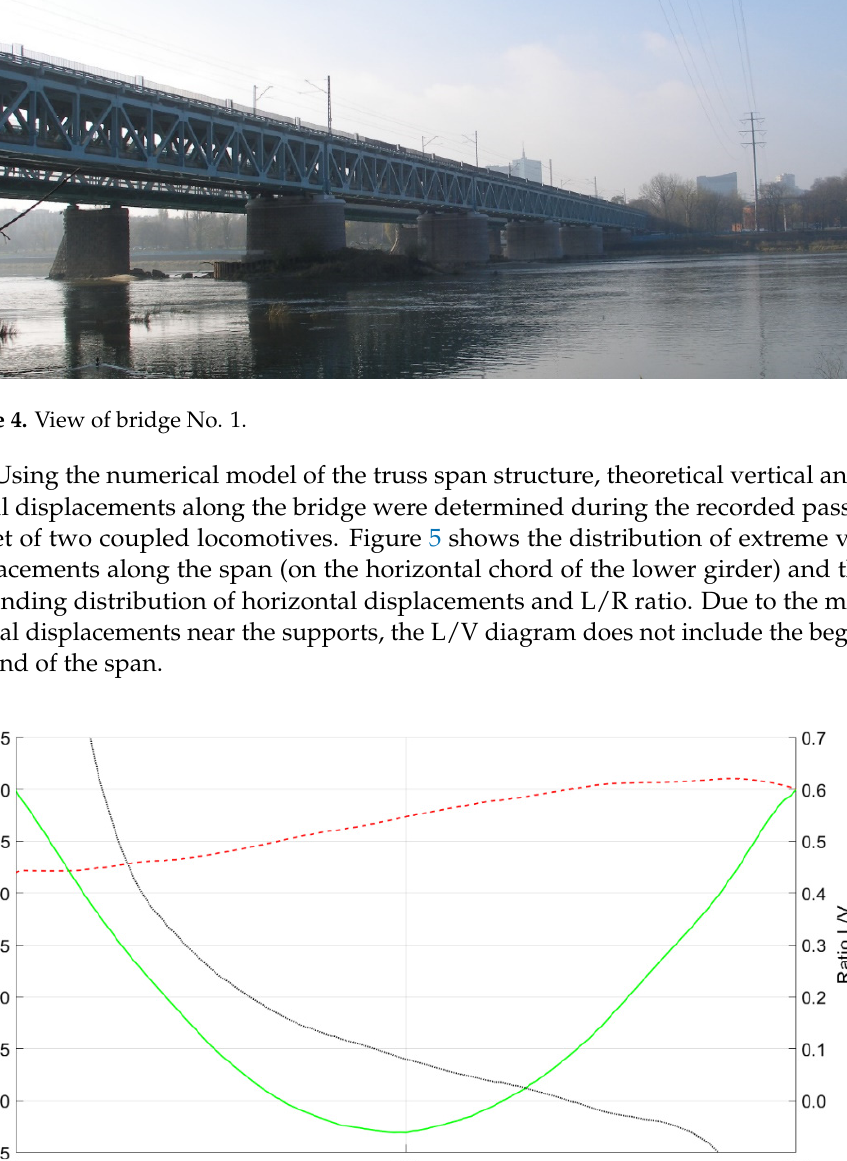
Figure 5. Results of calculation for passage of two coupled locomotives: left axis—the calculated extremal vertical and simultaneous horizontal displacement along the span; right axis—ratio L/V.